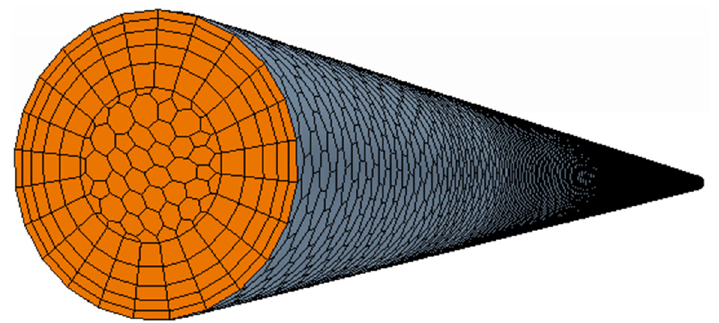
Figure 3. Polyhedral meshing of the water inside the